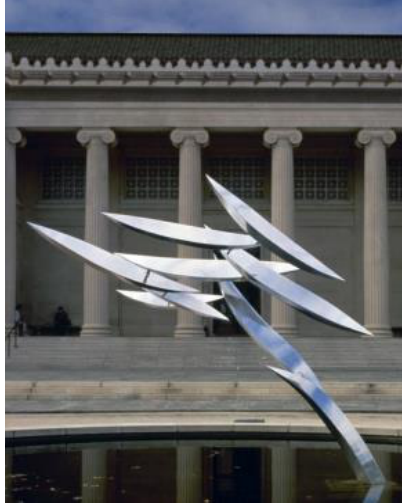
Figure 8. Wave , by Lin Emery, 1988. Polished hollow aluminum forms mounted on precision, all-weather steel bearings, 457 × 427 cm. New Orleans Museum of Art